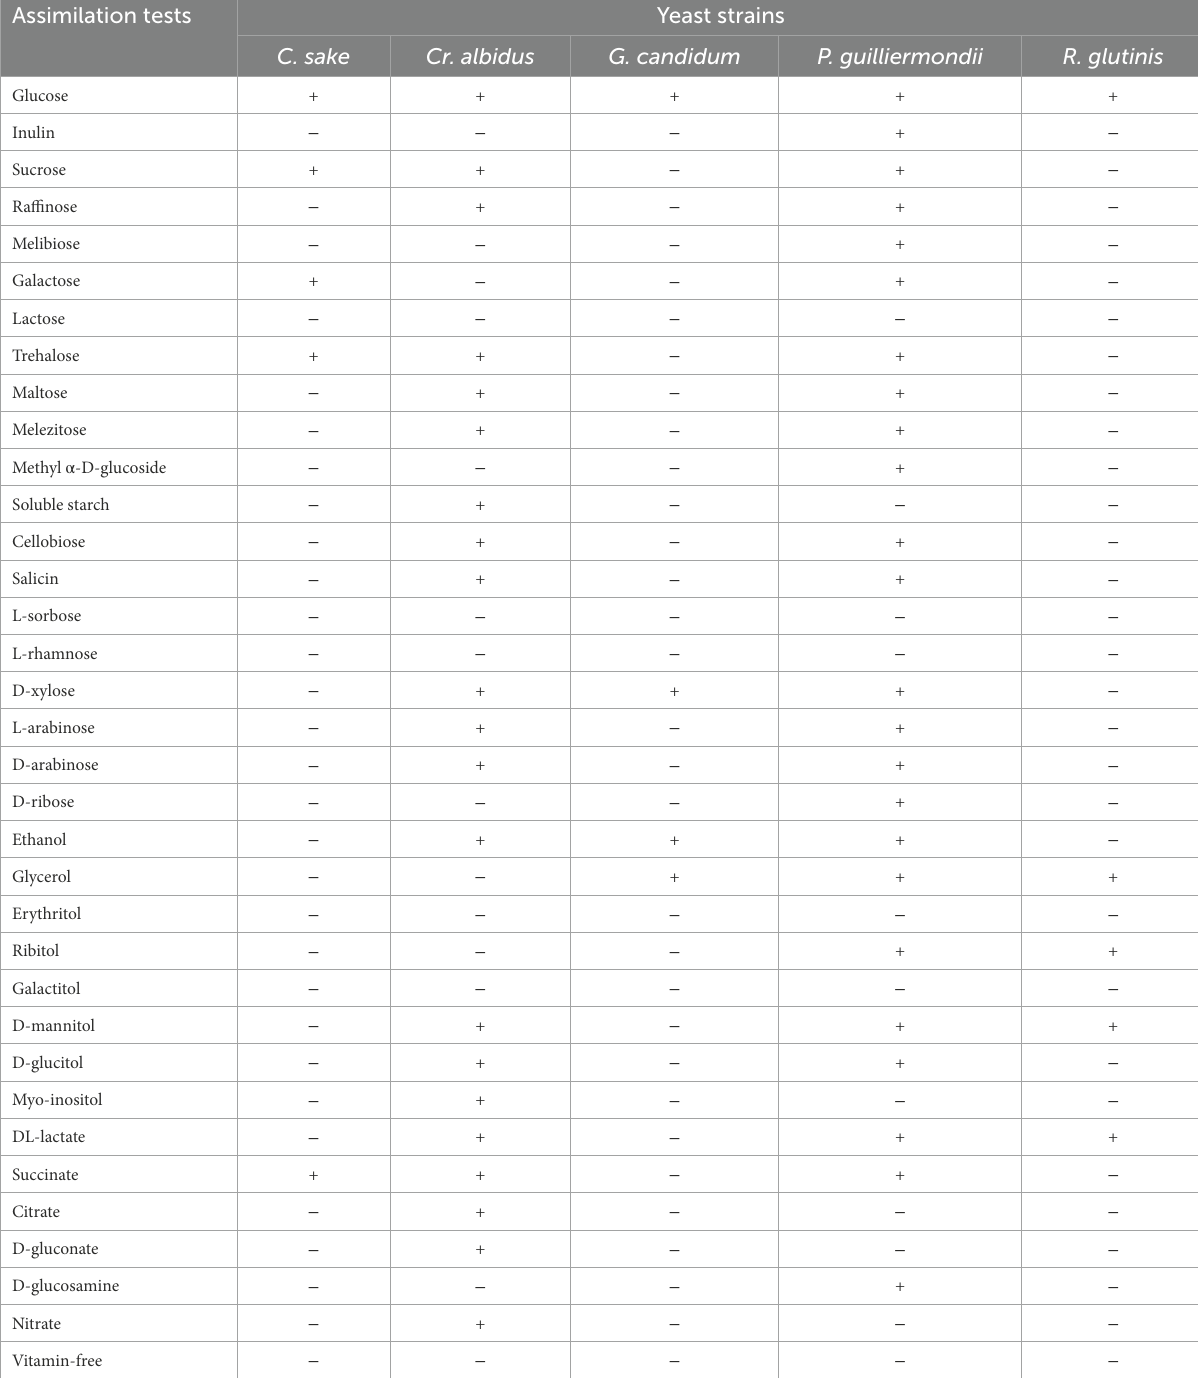
TABLE 5 Auxanogram of yeast strains contaminating strawberry fruits from the two localities Loukkos and